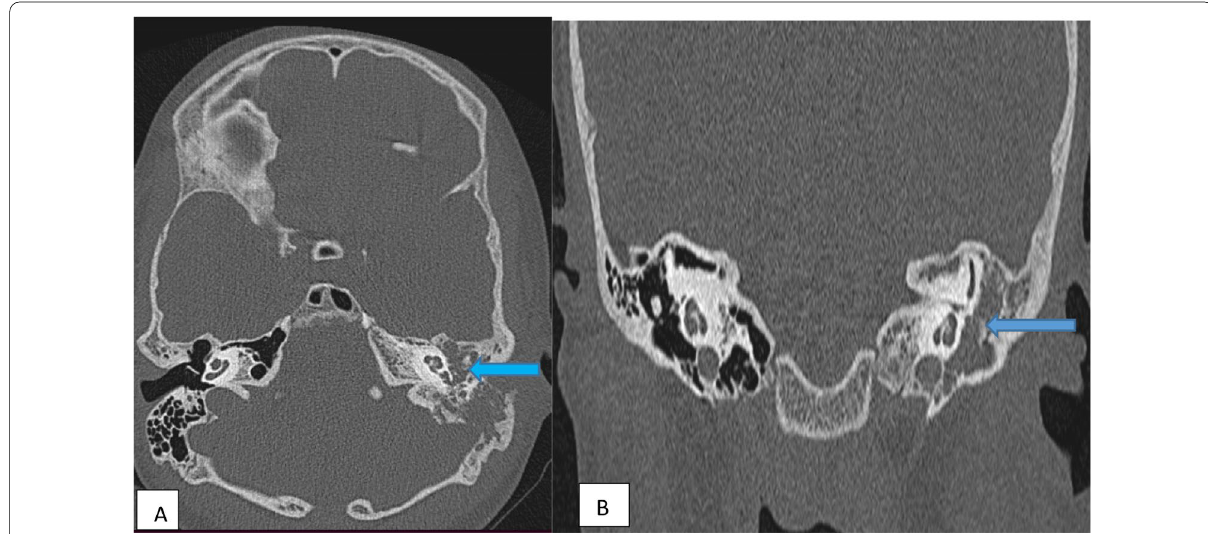
Fig. 1 HRCT temporal bone axial section ( A ) and coronal section ( B ) showing destruction of left petrous temporal bone with erosion of ossicles (blue